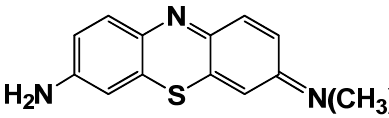
Figure 1. Chemical structure of Azure A.